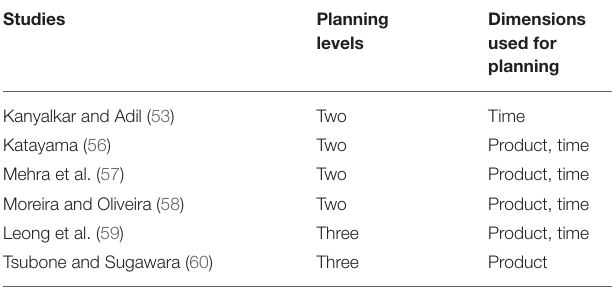
TABLE 2 | The summary of studies on hierarchical planning